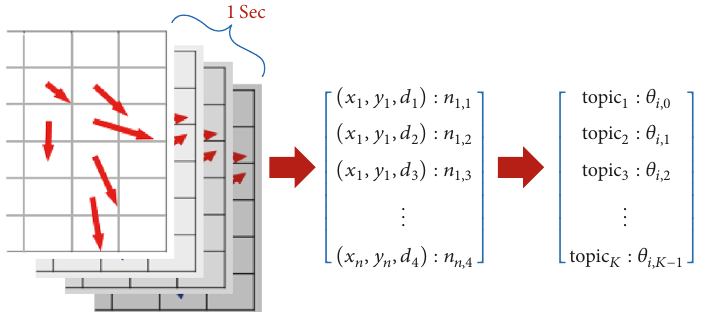
Figure 8: OF extraction output and LDA topic distribution for 𝑖 th one-second clip. (𝑥, 𝑦) denotes the coordinate of grid intersection point or block. 𝑑 is one of four directions, namely, up, down, left, and right. 𝑛 is the number of OFs acquired in one second. 𝜃 𝑖,𝑗 is the ratio of 𝑗 th topic in 𝑖 th document. 𝐾 is the number of LDA topics.